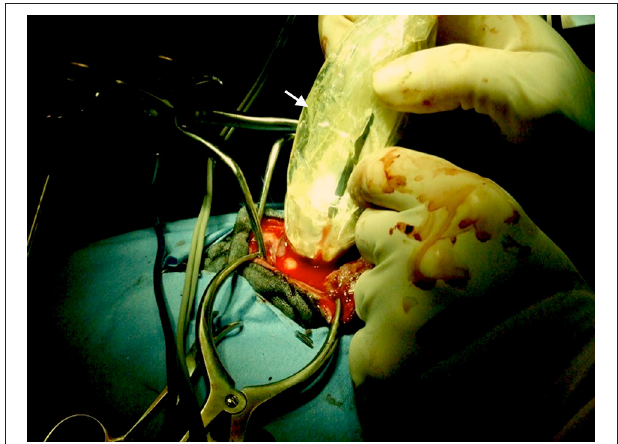
FIGURE 1 | Intraoperative photo showing ultrasound transducer covered with a sterile sleeve (white arrow) and applied directly to the cerebral cortex during a rostrotentorial craniectomy.